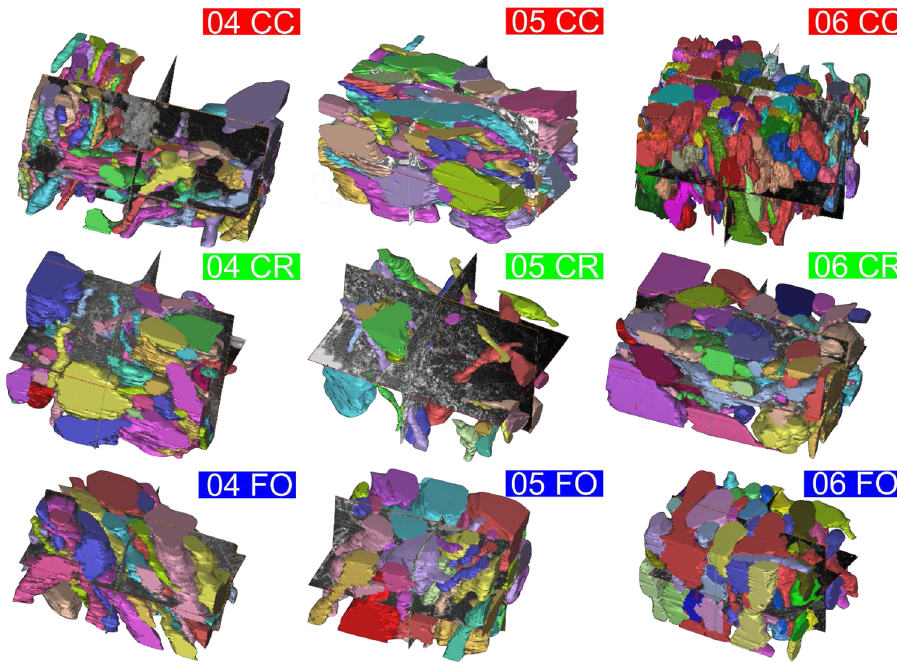
Fig. 7 Cytoarchitecture of the FIB-SEM 3D reconstructed volumes. The samples appear to form unidirectional bundles in the majority of the cases, con fi rming axonal structures ordering for all WM areas considered in this investigation. CC shows an organized cytostructure with sample 04 CC showing the least unidirectional structure of the axons (this is likely due to the sampling being performed at the edge of an axonal bundle). CR presents the lowest unidirectional behaviour in all samples, when compared to the other areas. The fornix exhibits a high unidirectionality in all of the samples (04 FO, 05 FO, and 06 FO) and it also displays the broadest distribution of axons dimensions for the three areas; this could also be due to the more prominently degenerated layers of myelin. The axonal density, calculated as number of axons over the scanned volume, ranges between the areas. CC shows the highest axonal density of circa 2 × 10 7 ± 5 × 10 6 axons/mm 3 , the CR of 1.5 × 10 7 ± 5 × 10 6 axons/mm 3 and the FO of 1.1 × 10 7 ± 3 × 10 6 axons/mm 3 . In more engineering terms, the Volume Fraction has been calculated as the fraction between the total sum of the volume of the axons and the total volume scanned. FO shows the highest volume fraction of circa 0.51 ± 0.05, the CC values around 0.45± 0.12 and the CR of 0.37 ±